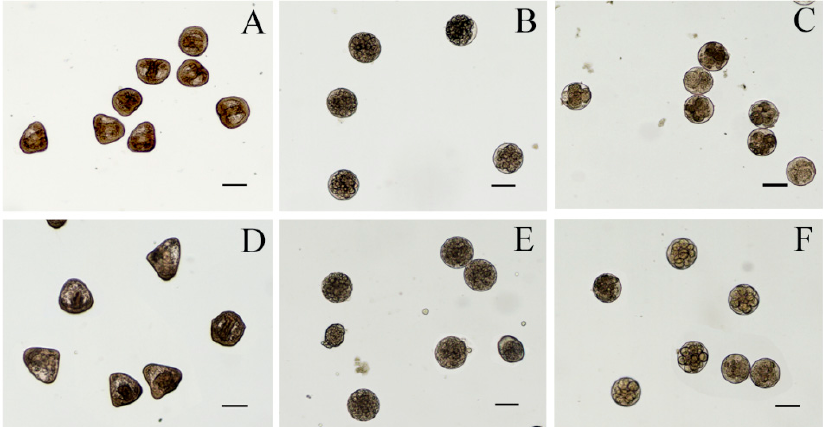
Figure 3. Micrographs of P. lividus embryos after 24 h of treatment with cyanobacteria extracts. ( A ) Control sample; ( B , C ) sea urchin embryos treated with aqueous extracts from Cyanobium sp. ITAC108 and Synechococcus sp. ITAC107, respectively; ( D ) sea urchin embryos treated with hexane extracts from Synechococcus sp. ITAC107; ( E , F ) sea urchin embryos treated with methanolic extracts from Cyanobium sp. ITAC108 and Synechococcus sp. ITAC107, respectively. Bar represents 100 µm.